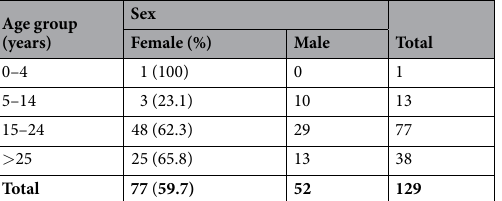
Table 1. Age and sex breakdown of participants of the nasopharyngeal swabbing exercise.